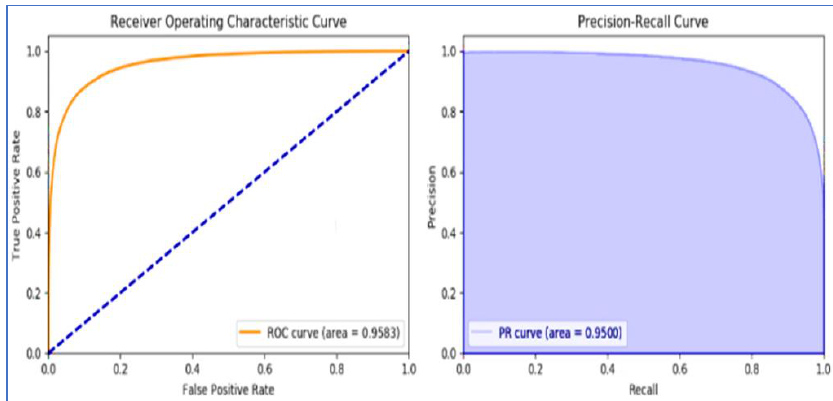
Figure 15. Gradient Boosting Tree Classifiers ROC.